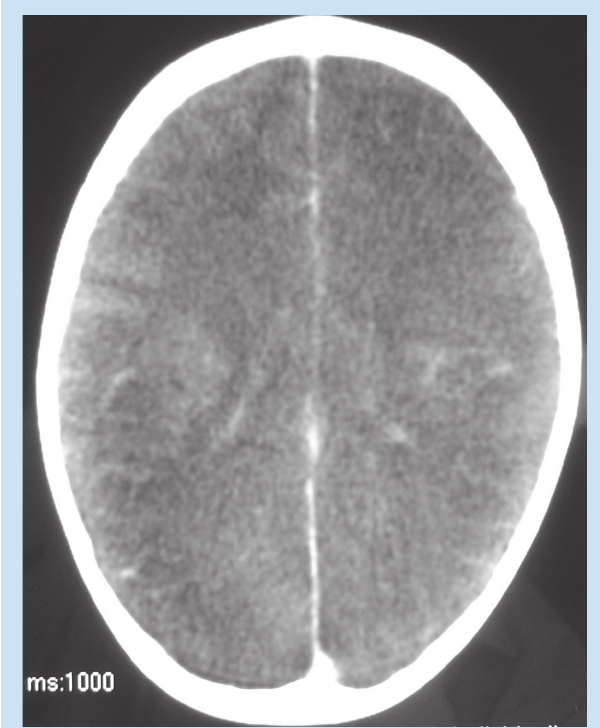
Fig. 2.3c. Ulegyria (mushroom-shaped gyri) are seen at the anterior watershed areas. The deep portion of the gyrus is more affected than the superficial portion due to different susceptibility to hypoxia.